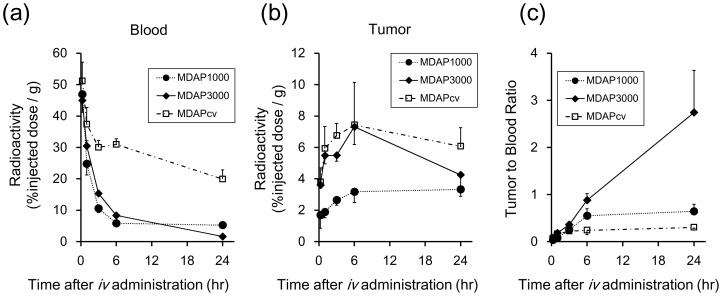

In vivo biodistribution experiment in HT1080-bearing mice with intravenous injection of MDAP1000, MDAP3000, and MDAPCV.(a) Time radioactivity curves in blood. (b) Time radioactivity curves in tumors. (c) Tumor to blood radioactivity ratios.